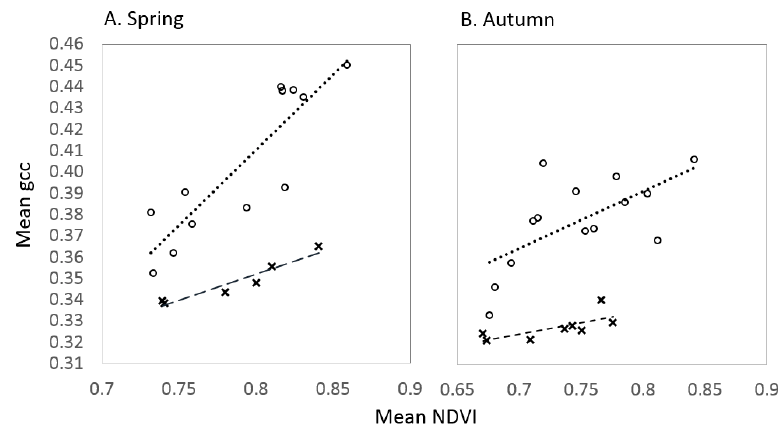
Figure 5. Correlation between spring ( A ) and autumn ( B ) NDVI and greenness captured by the Smokylook (dotted line, open circles) and Smokypurchase (dashed line, crosses) PhenoCam. NDVI values are the average for all deciduous forests in the Park within a 100 m elevation band centered on the PhenoCam elevation.